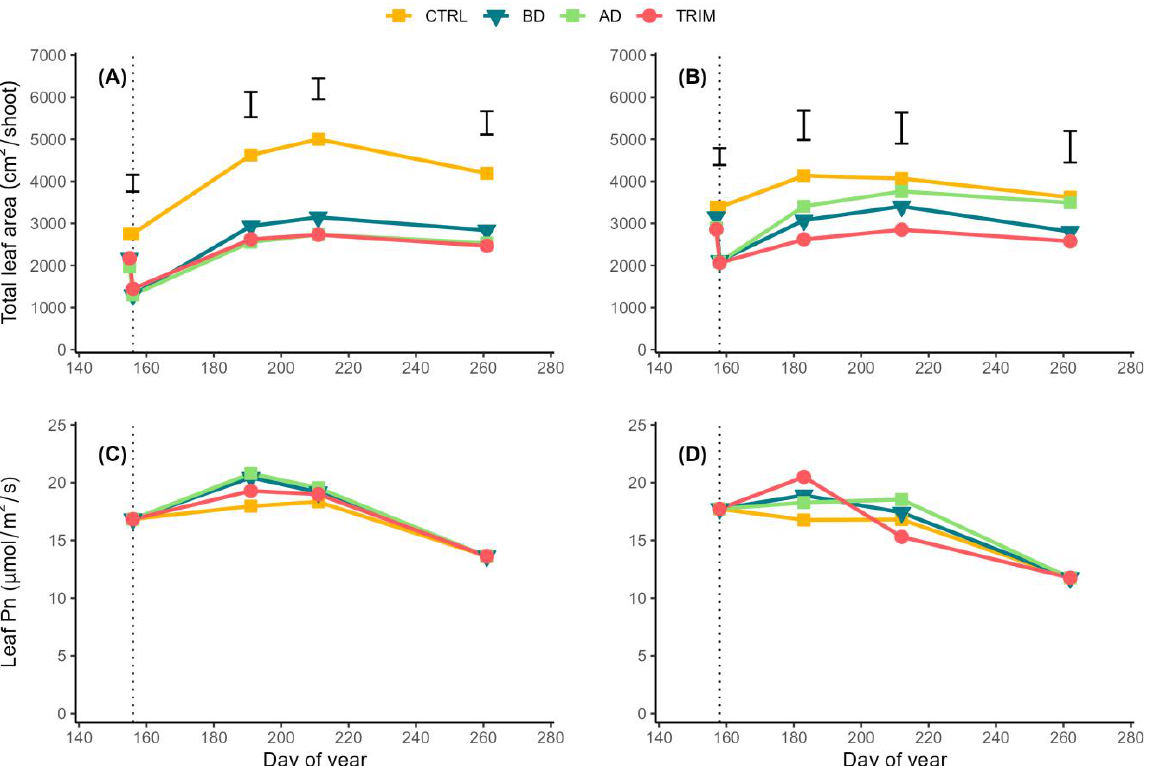
Figure 1. Seasonal pattern of total shoot leaf area ( A , B ) and leaf net photosynthetic rate, Pn ( C , D ) in ‘Aglianico’ ( A , C ) and ‘Casavecchia’ ( B , D ) vines exposed to four canopy management treatments (CTRL: control; BD: basal defoliation; AD: apical defoliation; TRIM: shoot trimming). Separately for each measuring data, vertical bars indicate least significant differences (LSD) between treatments (LSDs were calculated only when differences between treatments were significant according to one- way ANOVA). Dotted vertical line indicate the dates of treatment application (day of year 156 and 158 for ‘Aglianico’ and ‘Casavecchia’,